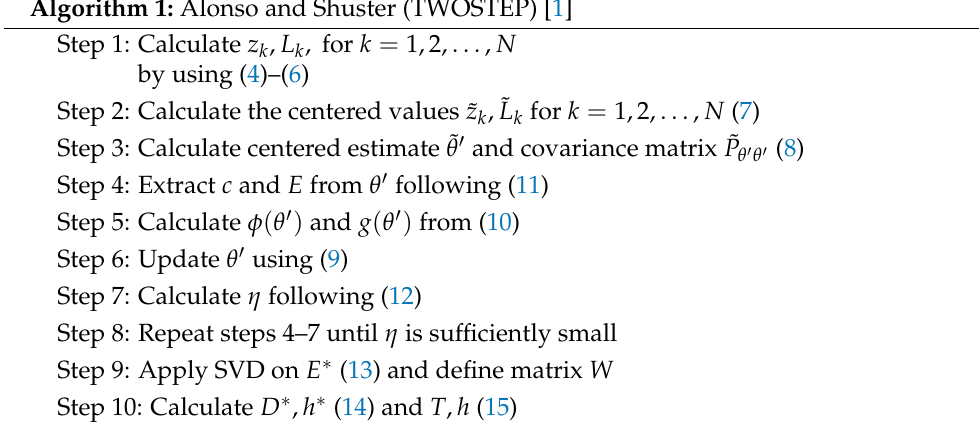
Algorithm 1: Alonso and Shuster (TWOSTEP)